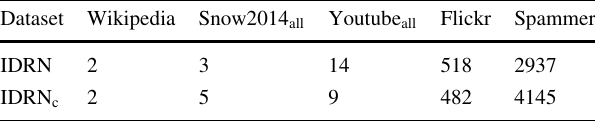
Table 5 Summary of running time (in s) of IDRN and IDRN c in each validation process by using 10% training data and 90% testing data Dataset Wikipedia Snow2014 all Youtube all Flickr